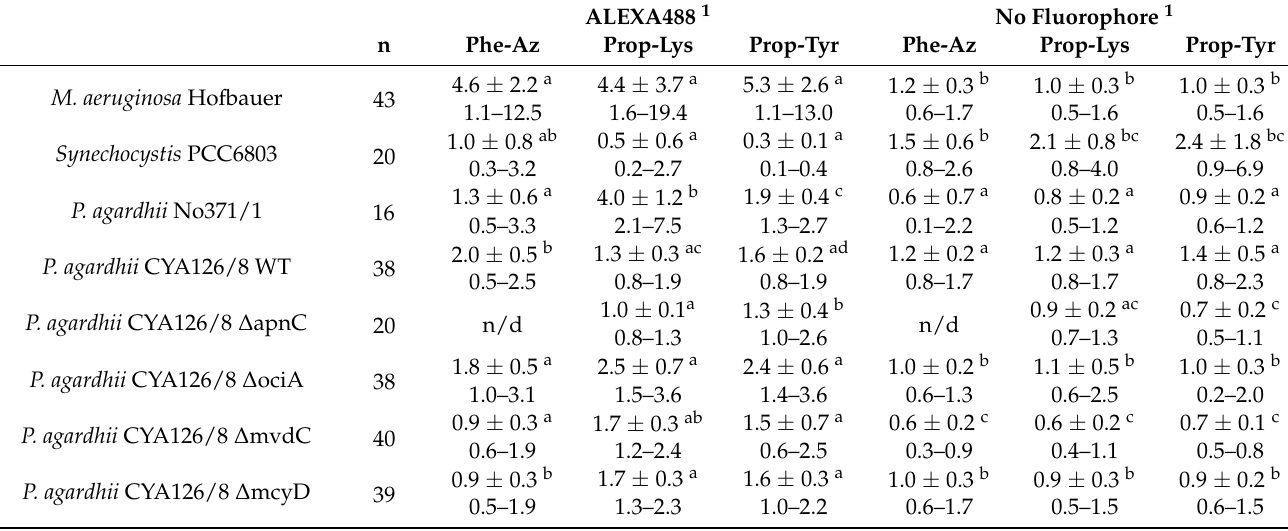
1 For each strain, treatments were compared using Kruskal–Wallis ANOVA on Ranks. We found statistically significant differences between the treatments ( p < 0.001) in all of them. Superscripts indicate homogeneous subgroups not significantly different at p < 0.05 using post-hoc pairwise comparison (Tukey’s test); n/d: no